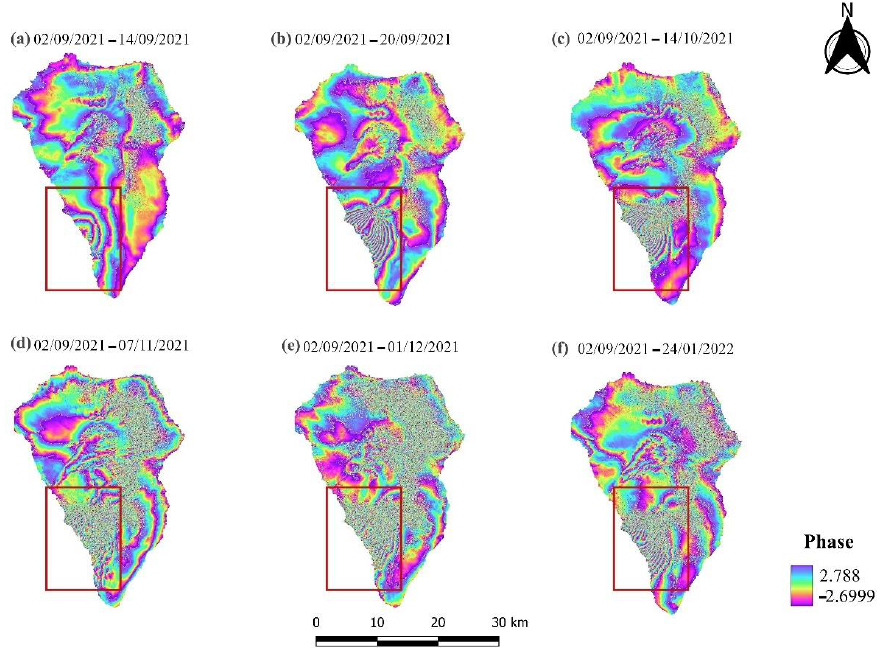
Figure 4. Multitemporal Sentinel-1 ascending interferograms. The red square indicates the area displaying the greatest deformation.